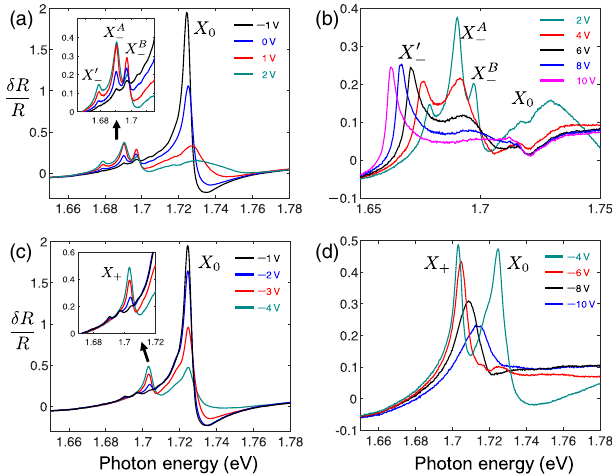
FIG. 1. Optical reflection spectroscopy of ML-WSe 2 at 4 K. The gate voltage controls the charge density in the ML. (a,b) Optical spectra for low and high electron densities, respectively. The optical sideband is indicated by X − 0 . (c,d) The respective results for hole densities. The sample is n type, so a gate voltage of about − 1 V is required to deplete the ML from resident electrons. These results were kindly provided to us by Wang, Mak, and Shan. Reference [15] includes details of the experiment with a similar